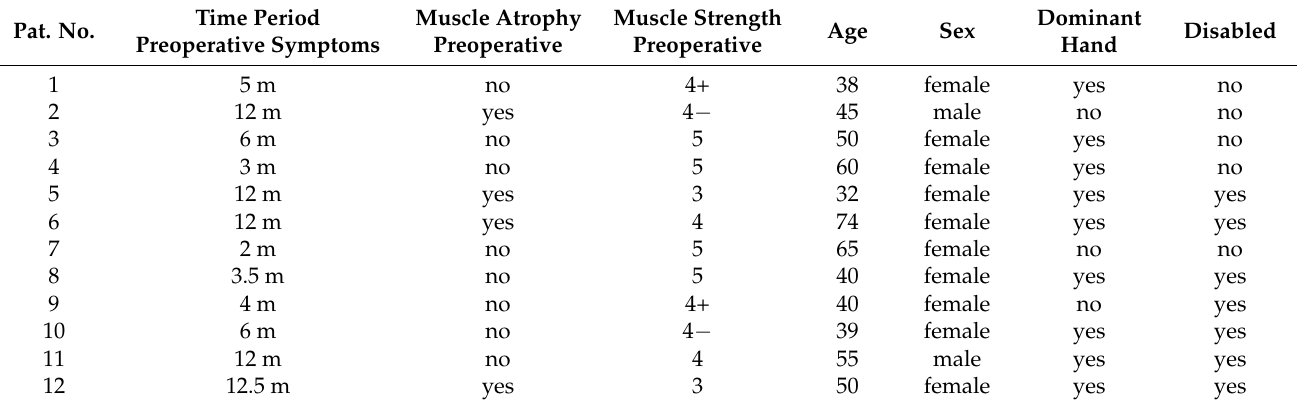
Table 2. Clinical presentation of patients in detail.